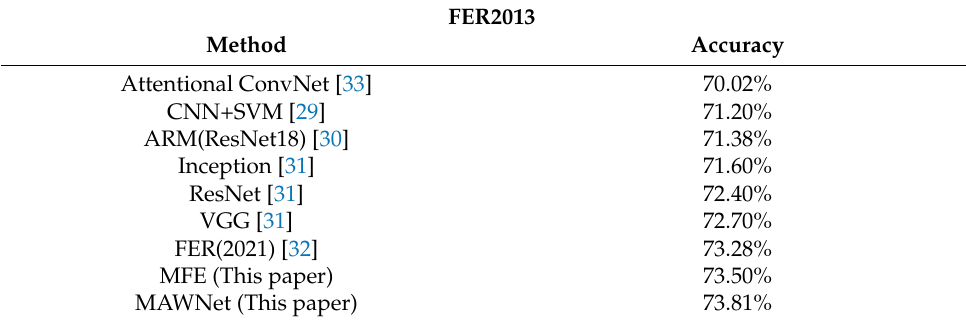
Table 3. Accuracy of different methods on the FER2013